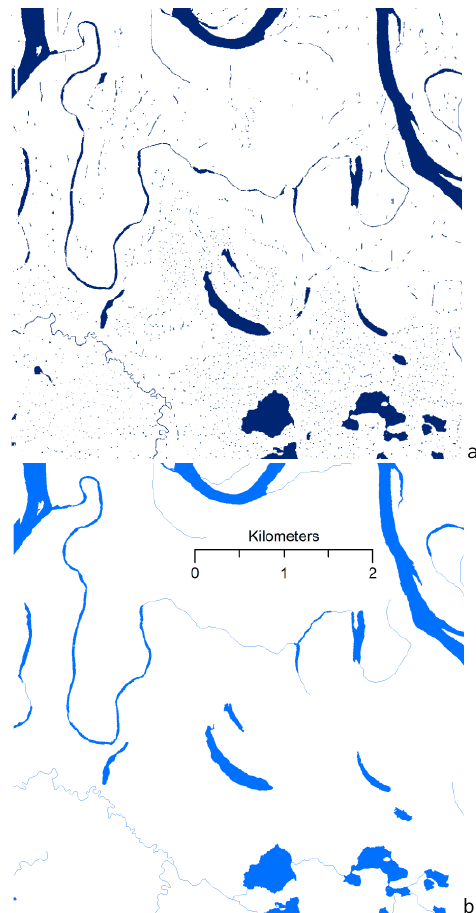
Figure 10. Example of typical hydrography predictions from the base model (a), and the reference vector hydrography